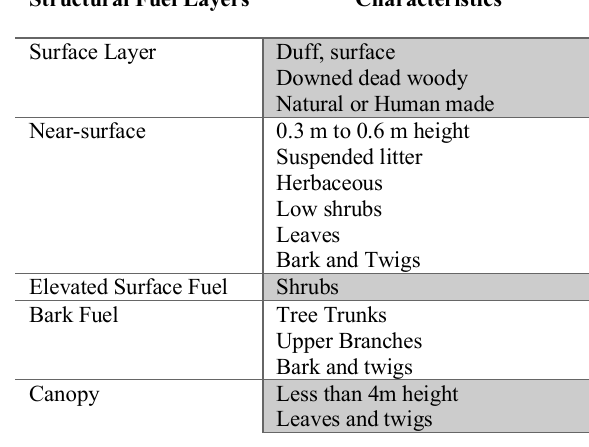
Table 1: Characteristics of fuel (Hines, Tolhurst et al. 2010)